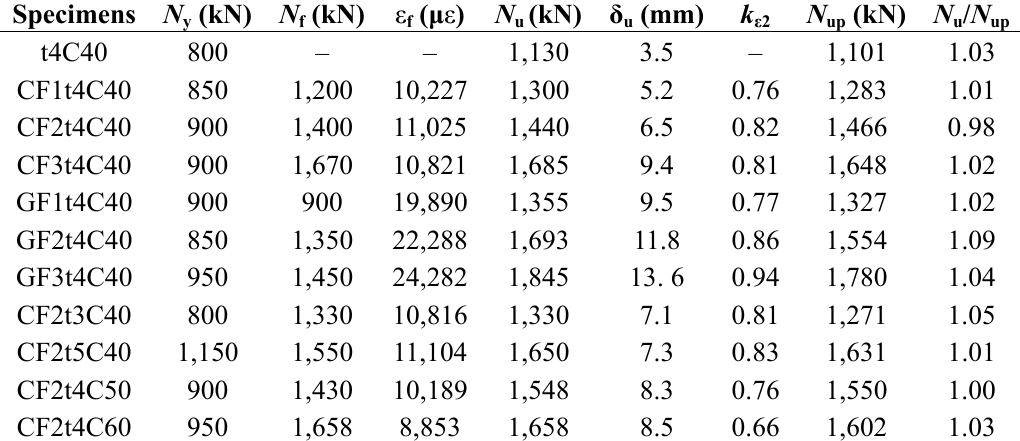
Table 2. Test results for the